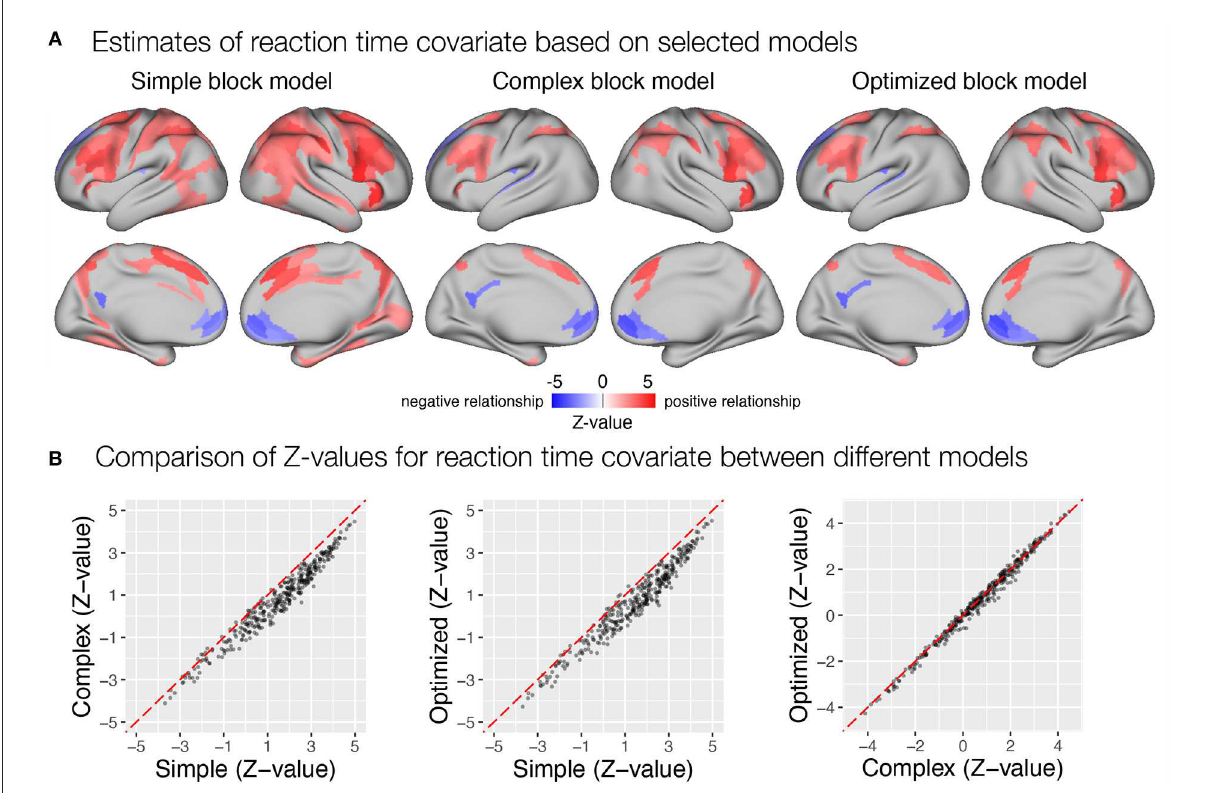
FIGURE10 Estimation of correlation between trial-to-trial variability in transient response and reaction times in the flanker study. (A) Whole-brain maps of significant β estimates reflecting covariability between trial-to-trial transient responses and reaction times are shown. (B) A comparison of Z -values obtained with different models. Each point represents a Z -value obtained for a brain parcel using the two models compared. The red diagonal presents equal